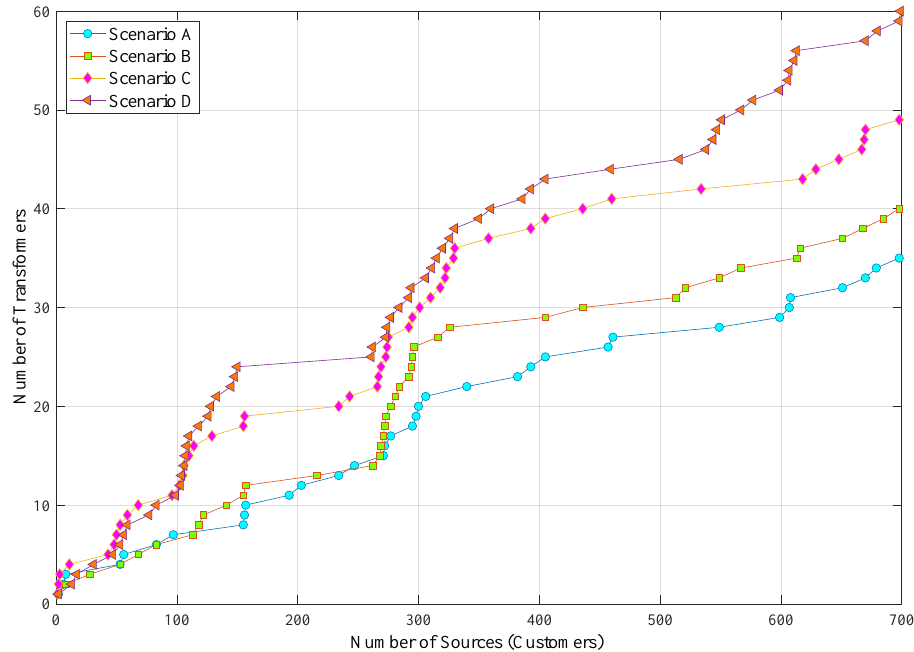
Figure 4. Number of transformers required related to the distance from the source to the